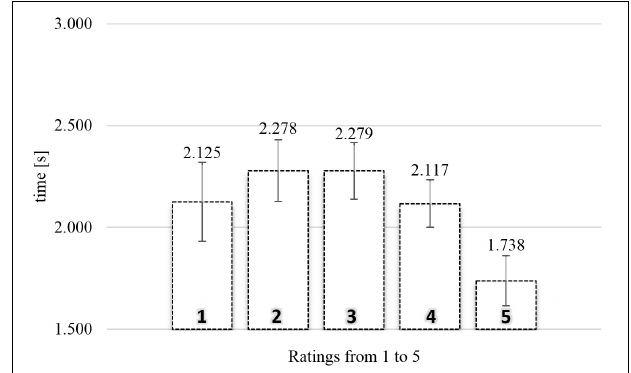
FIGURE 2 | Average exposure time of food images rated from 1 (“not like at all”) to 5 (“like very much”) in the self-paced non-exclusive evaluation ( N = 78). Error bars reflect the 95% confidence interval around the mean.